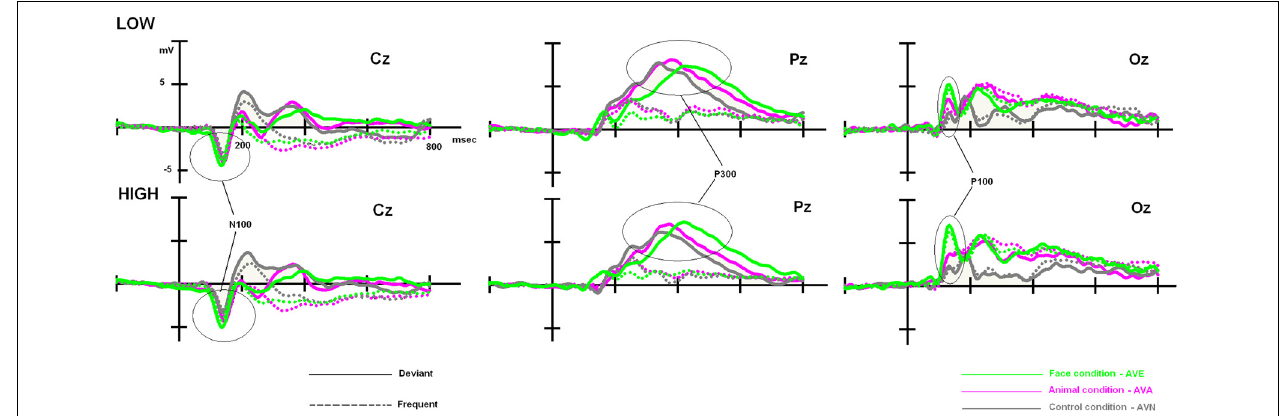
FIGURE 3 | Low- and high-alexithymic scores related to the three ERPs of interest (P100, N100, and P300), which were recorded during each bimodal task on their respective electrodes.